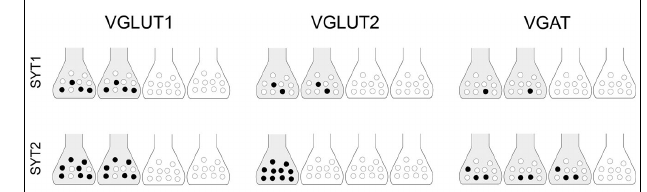
FIGURE 6 | Hypothetical distribution of SYT1/2 inVGLUT1 + and VGLUT2 + glutamatergic andVGAT + GABAergic cortical terminals. Based on a correlative analysis of confocal and immunoisolation data, the scenario proposed is highly schematic (e.g., the total amount of a SV-related protein is equally distributed among all positive terminals), and does not take into account the number of proteins/vesicles, but it emphasizes the concept that the amount of a SV-related protein is variable in positive terminals. Shaded terminals indicate terminals expressing a given protein; black circles indicate levels of expression of the protein in immunoisolated SVs. Four terminals make up 100%; similarly, 10 vesicles makes up